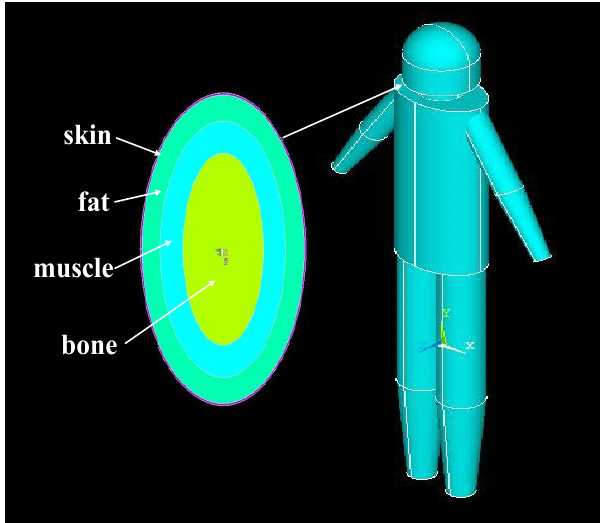
Figure 3. The torso of the whole body